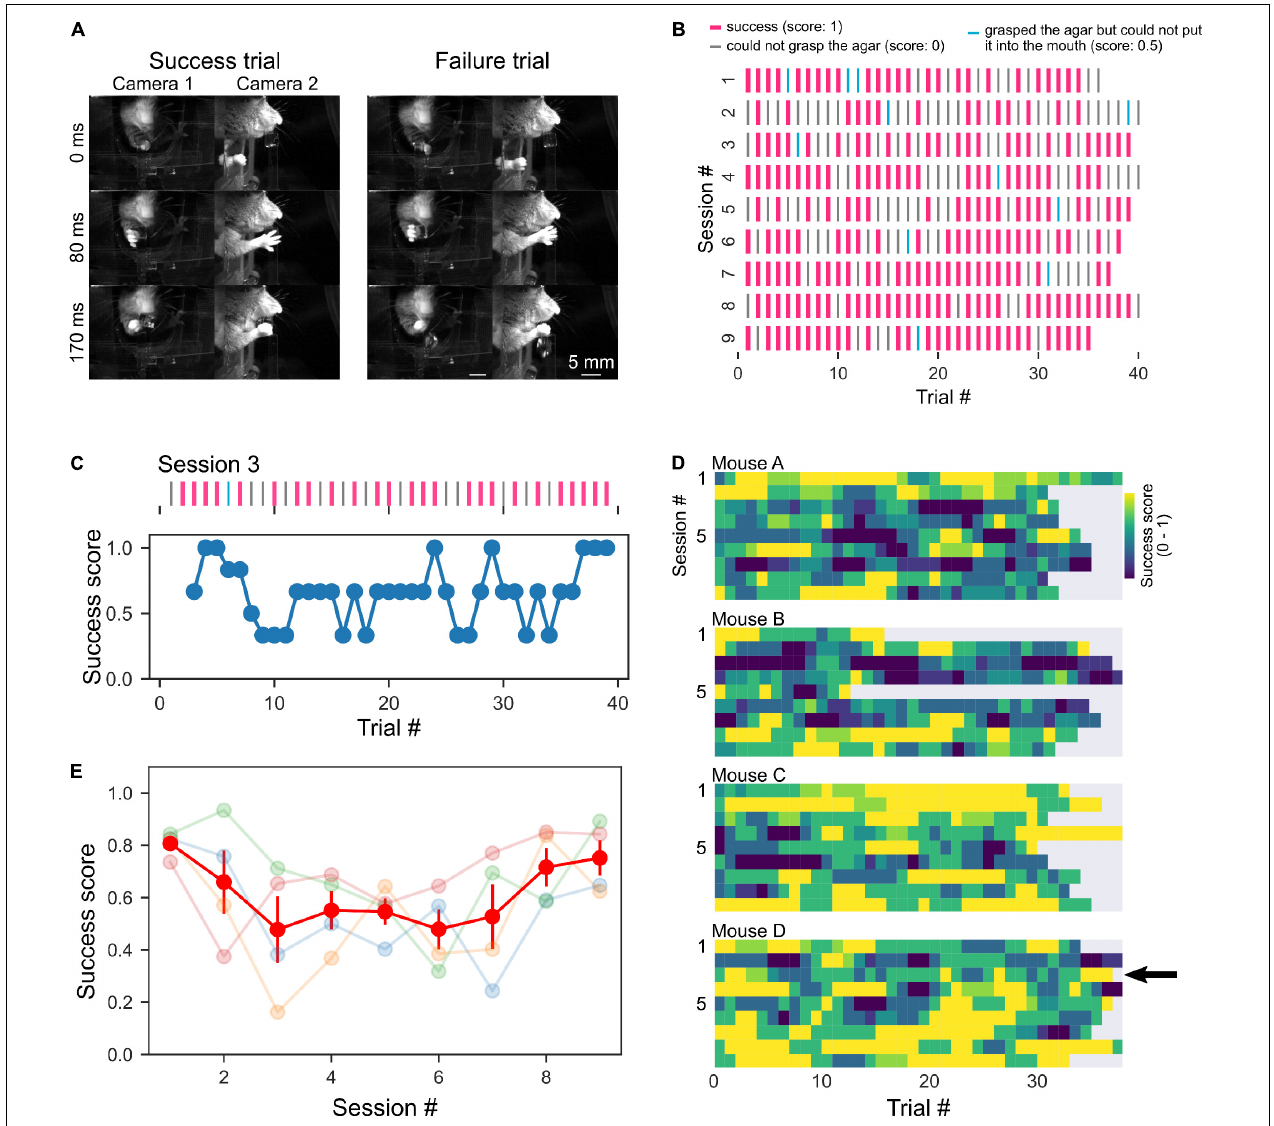
FIGURE 4 | High behavioral performance with short training. (A) Sequential photographs of RGR behavior by head-fixed mouse. Examples of success and failure (could not grasp the agar, “type 2 failure”, score: 0) trials of the same mouse are shown. The timestamp represents the time from the beginning of the right forelimb movement of the mouse. (B) A representative raster plots of the success and failure trials of a mouse. Pink lines indicate successful trials. Cyan lines indicate trials where the mouse grabbed the cube but dropped it before putting it in its mouth (type 1 failure). Gray lines indicate failure trials where the mouse dropped the cube before grabbing it (type 2 failure). (C) A representative example of moving average from raster plot in a session [session 3 shown in panel (B) ]. (D) Color plots of success scores in individual mice. The arrow indicates data in panel (C) . (E) Mean success scores were plotted across sessions. The light color plots show data from individual mice, and the red plot indicates the